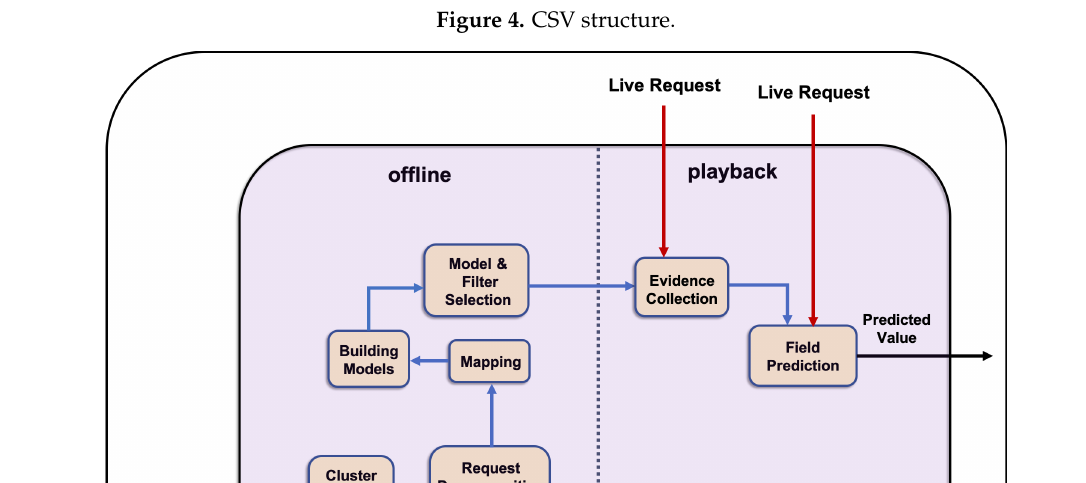
Figure 4. CSV structure.